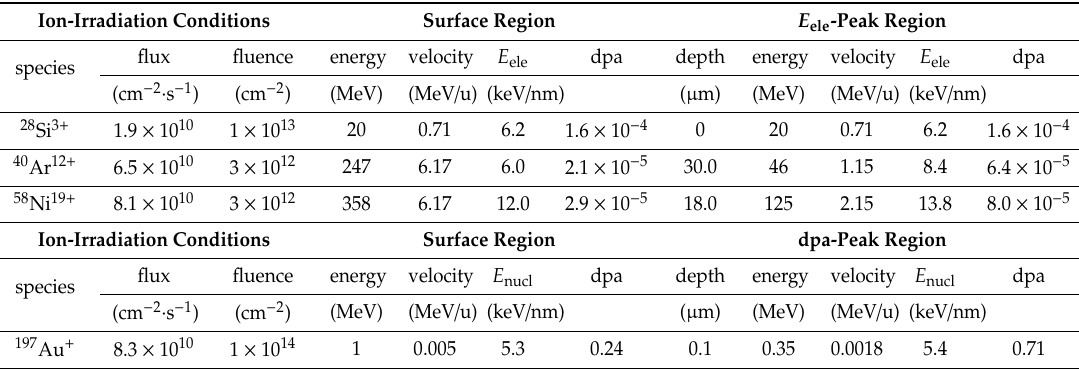
Table 1. SRIM simulation results corresponding to di ff erent ion-irradiation